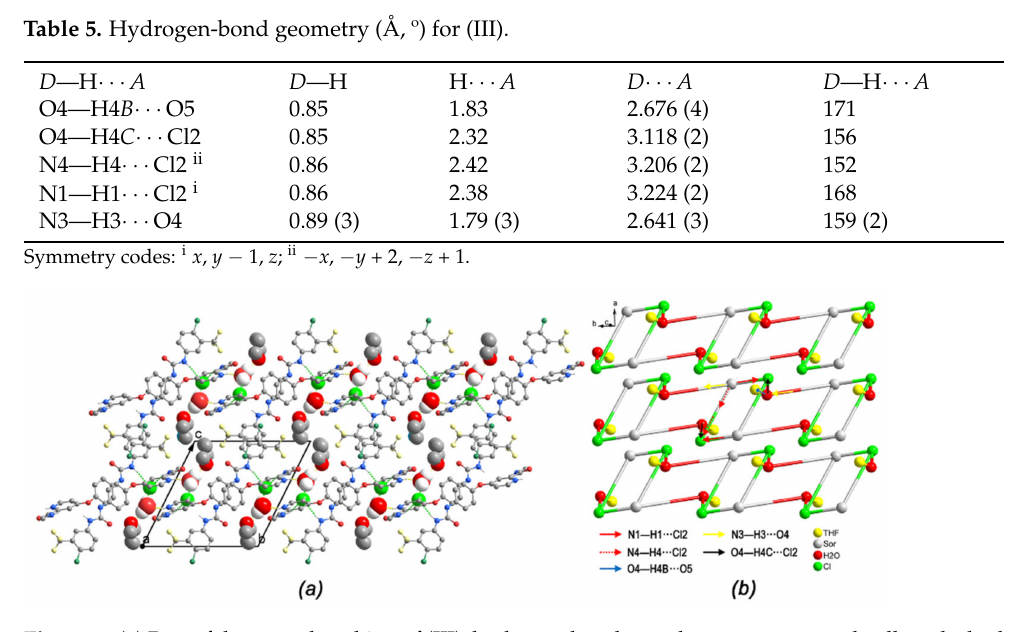
Figure 6. ( a ) Part of the crystal packing of (III), hydrogen bonds are shown as green and yellow dashed lines, H atoms not involved in hydrogen bond have been omitted for clarity; ( b ) 1,3,3,3-Connected tetranodal topological net representing the hydrogen bond chain structure of (III).